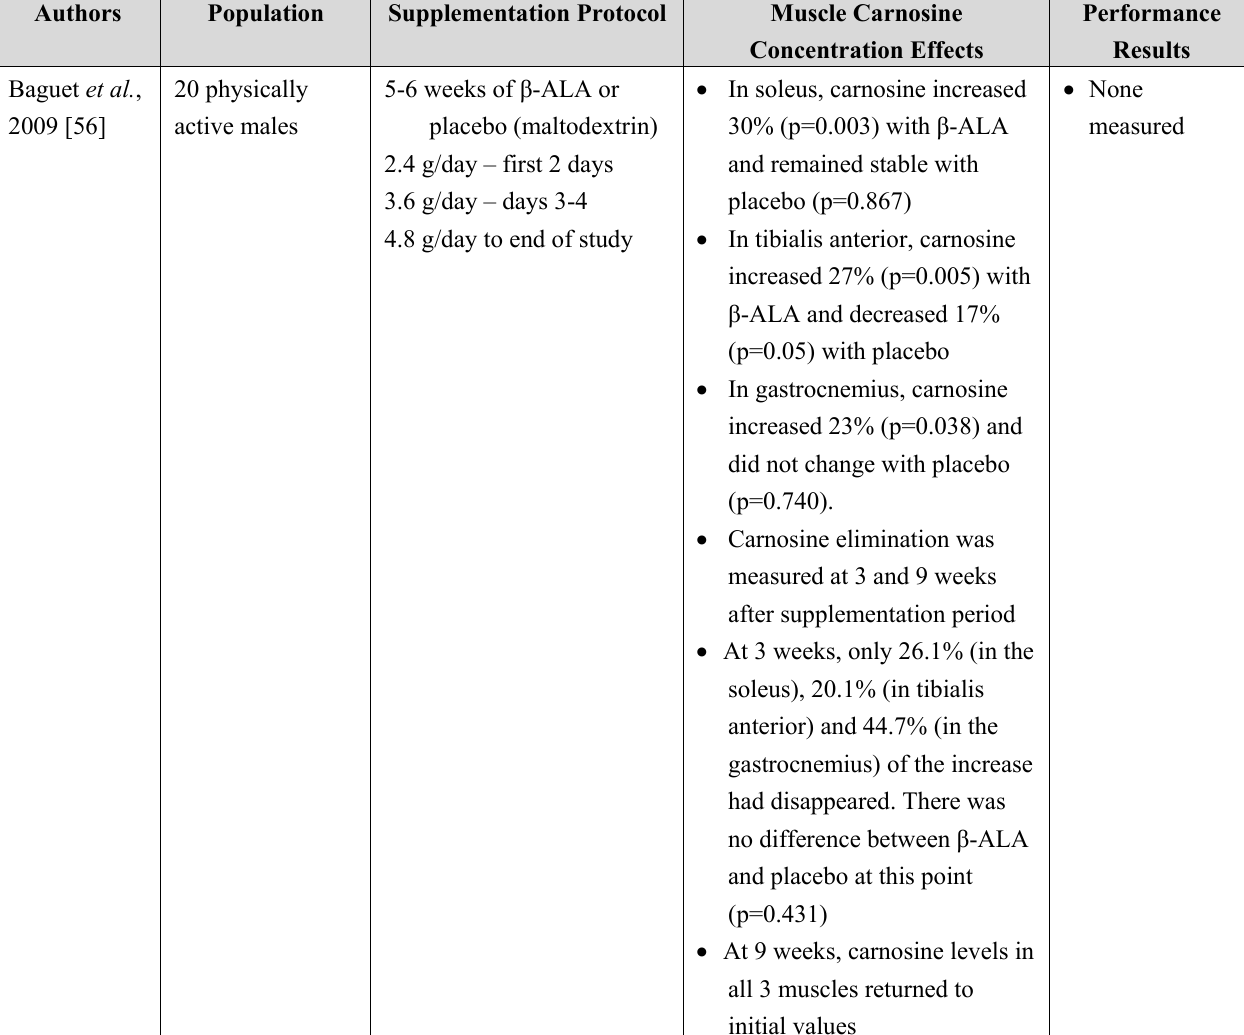
Table 1. Summary of the effects of β -ALA supplementation on muscle carnosine